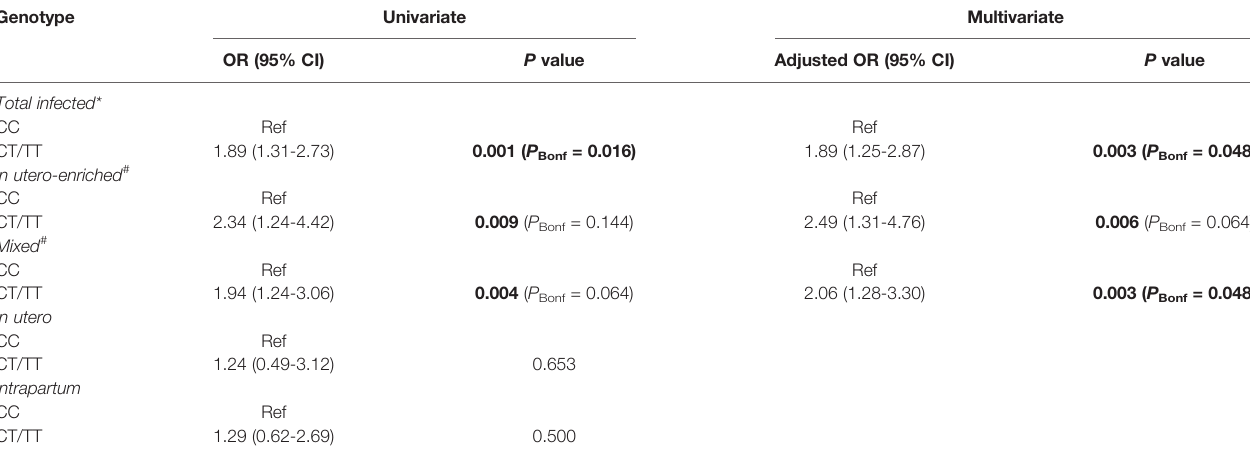
TABLE 4 | Univariate and multivariate analysis of the effect of FCGR2C c.134-96C>T on perinatal acquisition of HIV-1. Genotype